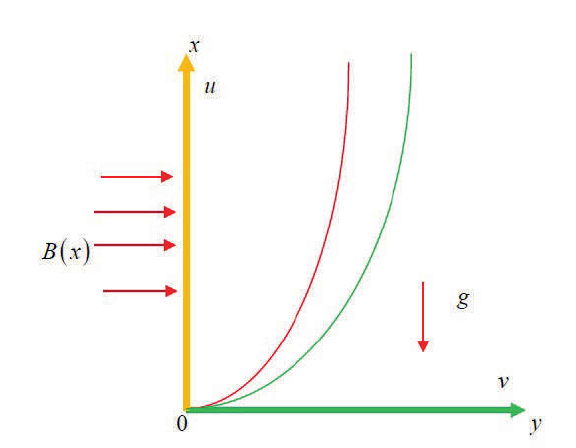
Fig. 1: Schematic diagram of the flow